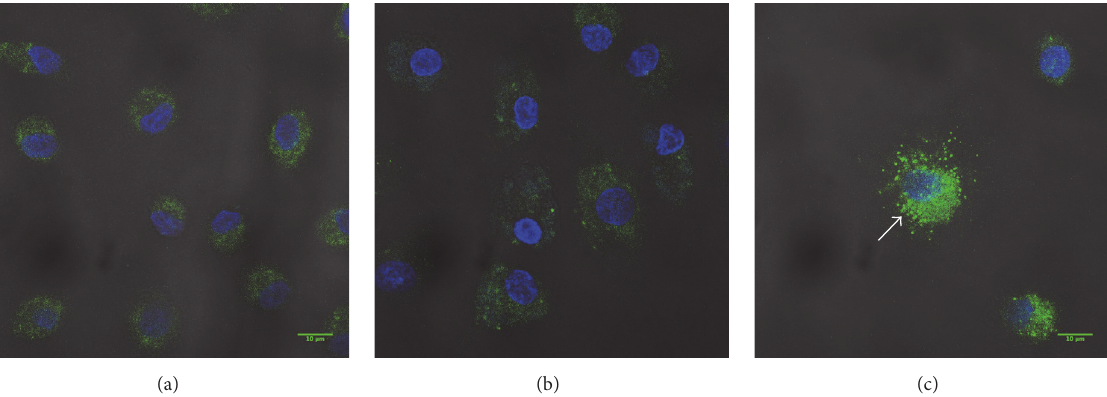
Figure 5: ATP modulates IL-1 𝛽 distribution in Ngo-infected MDM cells. IL-1 𝛽 expression was analyzed by confocal microscopy. (a) MDM cells, (b) Ngo-infected MDM. (c) Ngo-infected MDM treated with ATP. Images of IL-1 𝛽 (green) and DAPI (blue). Arrow pointed IL-1 𝛽 concentration. Scale bars 10 𝜇